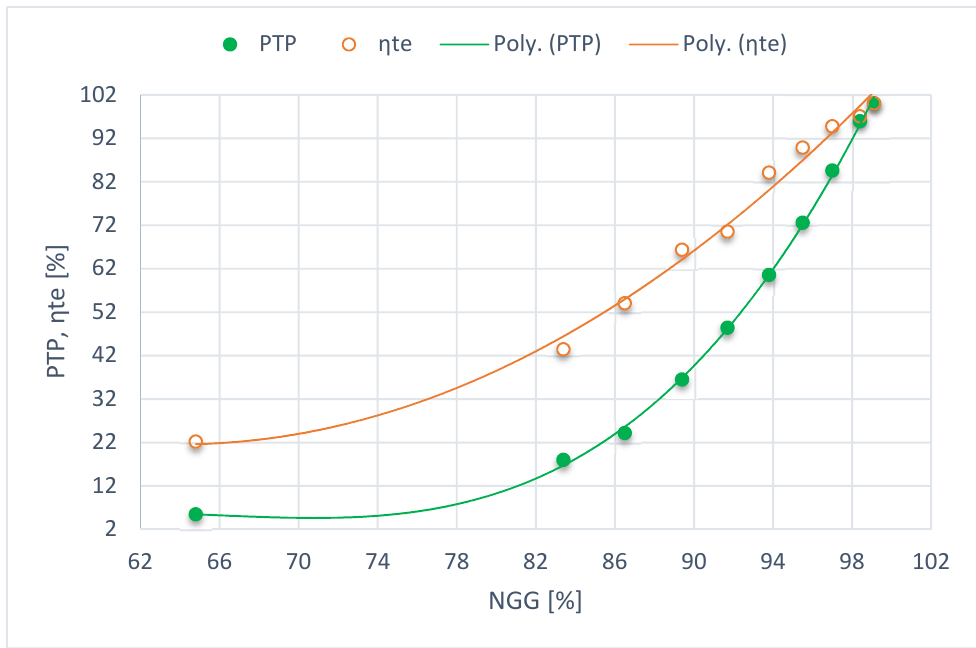
Figure 14. Engine power and the thermal efficiency percentage variation.